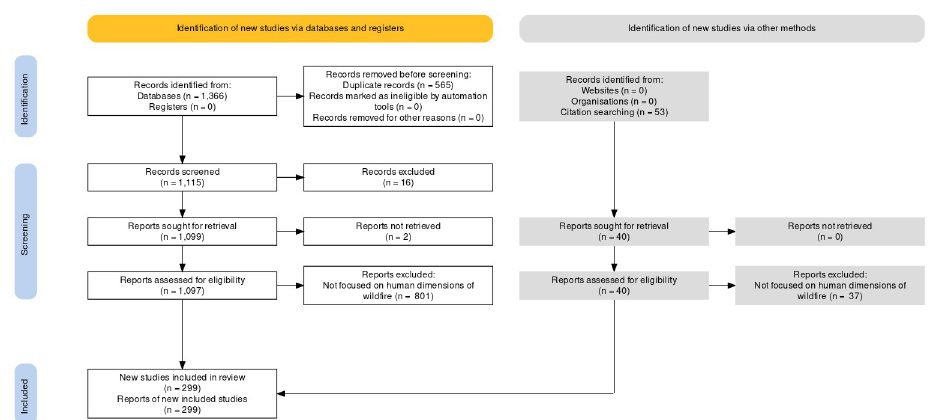
Fig 1. Diagram of record search and report selection based on PRISMA